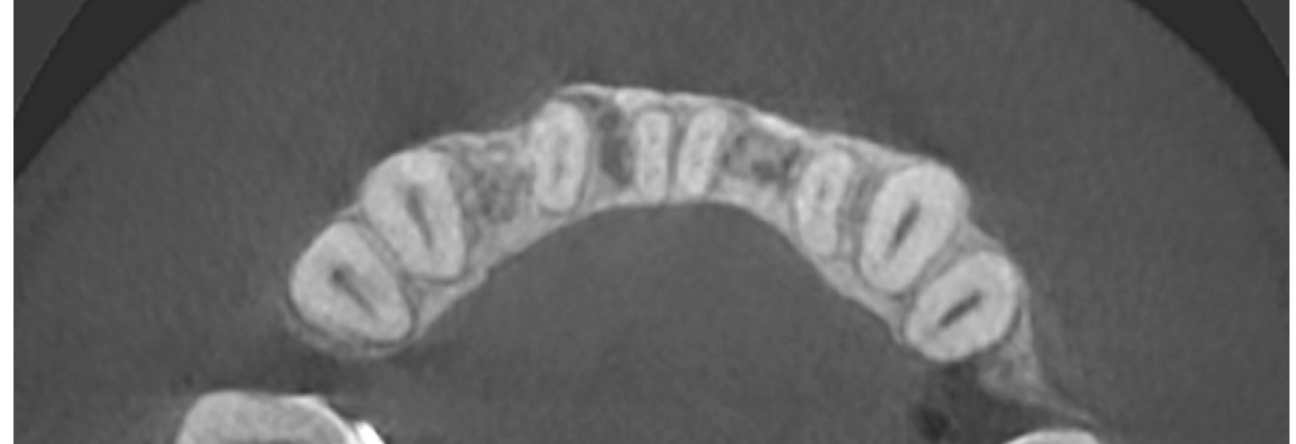
Figure 12. CBCT image two years after the surgical treatment—axial view. Appl. Sci. 2021 , 11 , x FOR PEER REVIEW